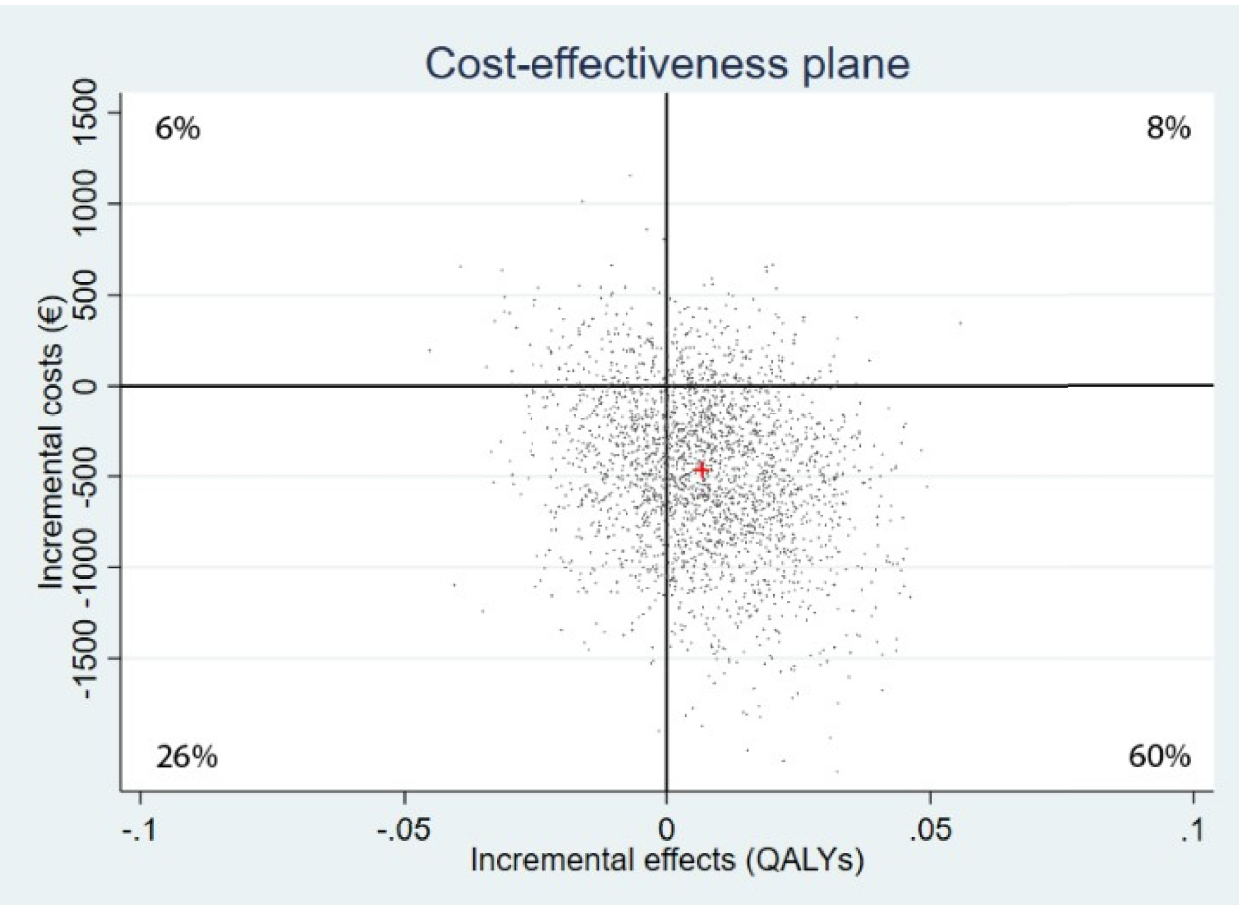
Fig 3. Cost-effectiveness plane reflecting the probability that blended ACT is cost-effective compared to CBT in terms of QALYs